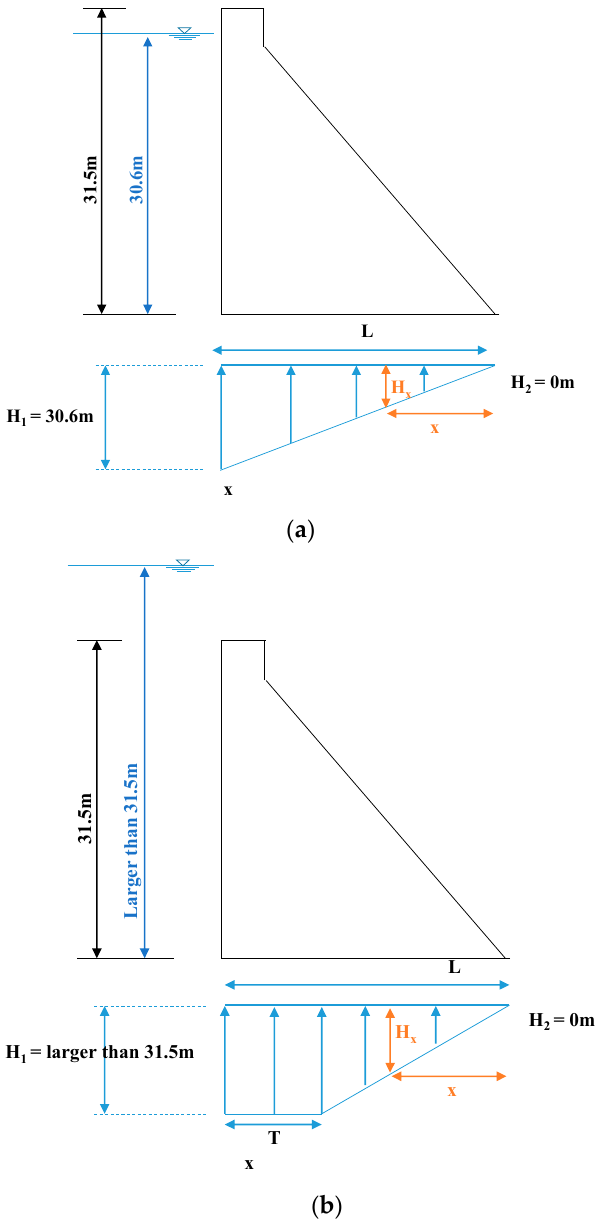
Figure 5. Uplift pressure ( a ) without a zero-compression region and ( b ) with a zero-compression region.